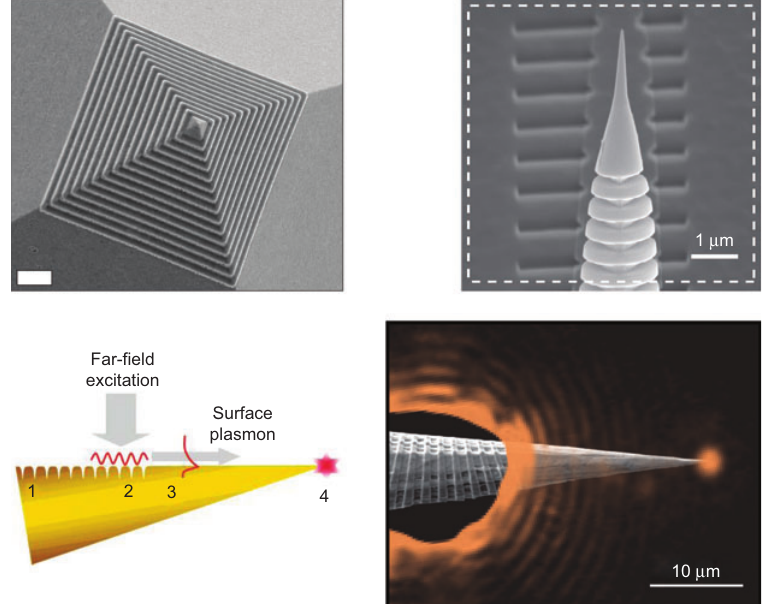
Figure 24 (Top left) Silver pyramid with a grating for plasmonic focusing (scale bar = 1 μ m). Reprinted with permission from [155] . Copyright 2010, American Chemical Society. (Top right) Silver nanocone with three-dimensional grating structure. Reprinted with permission from Macmillan Publishers Ltd.: Nature Photonics [156] , copyright 2011. (Bottom left) Schematic of a grating fabricated on the side of a scanning probe for local excitation of SPPs spatially removed from the imaging tip. Reprinted with permission from [157] . Copyright 2007, American Chemical Society. (Bottom right) SEM image of a gold tip with plasmonic grating fabricated via FIB, superimposed with an optical image of grating coupling and subsequent reradiation of nanofocused SPPs. Adapted with permission from [158] . Copyright 2012, American Chemical